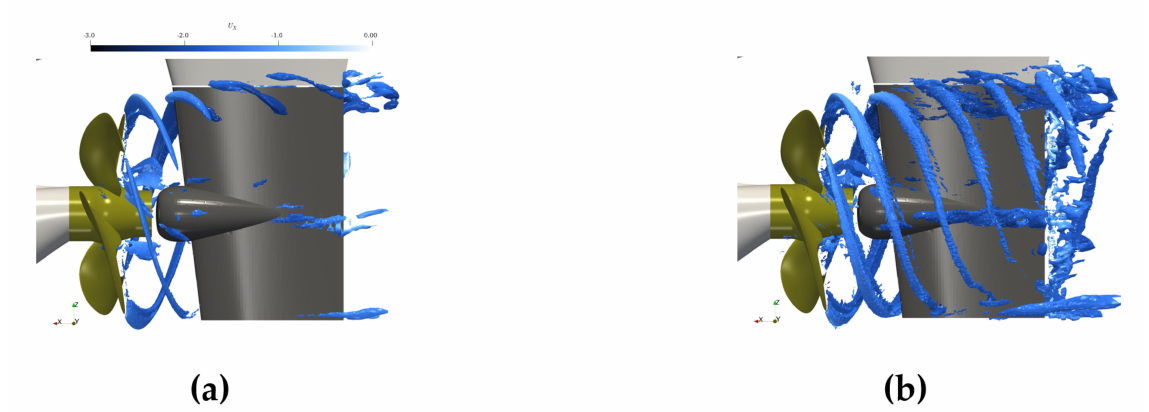
Figure 13. SCHOTTEL reference case 1. Comparison of RANS and ILES Q-criterion Q = 5 · 10 2 s − 2 at model scale on the same mesh: ( a ) RANS; ( b ) ILES.